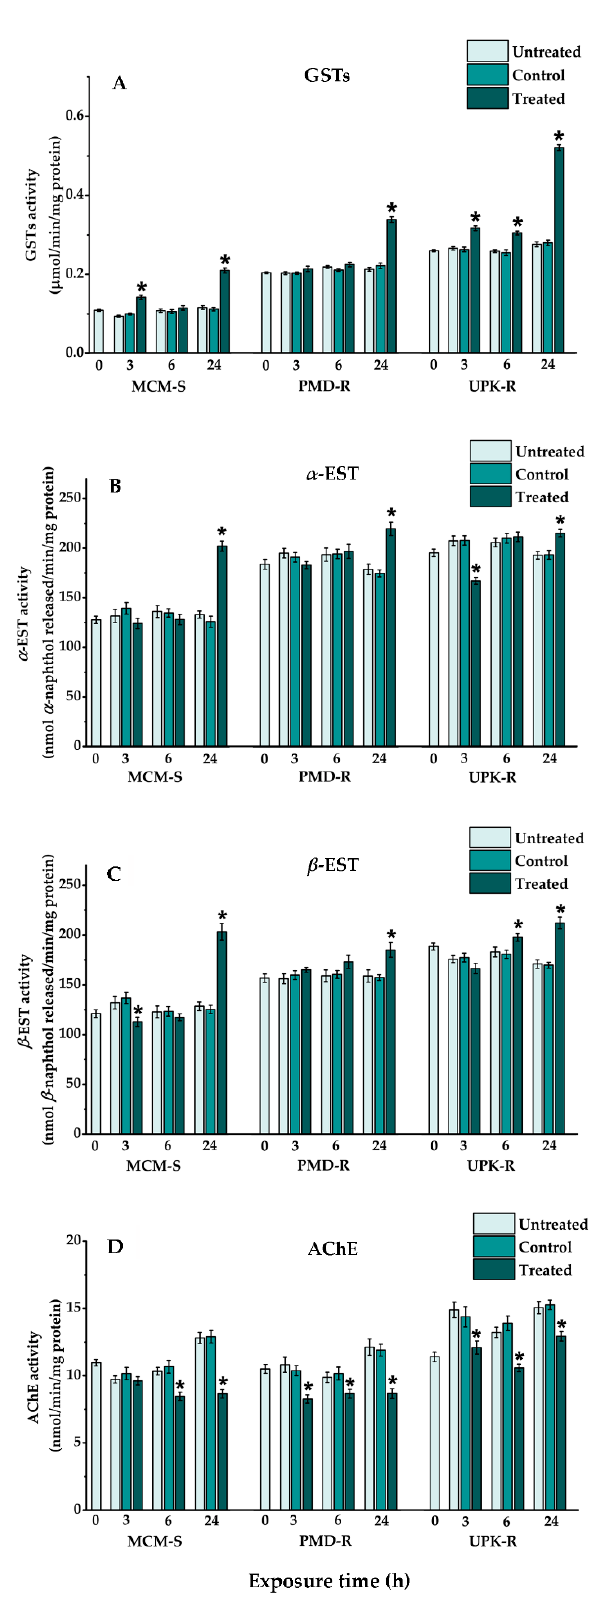
Figure 3. Activity levels of: GSTs ( A ); α -EST ( B ); β -EST ( C ); and AChE ( D ) in 4th instar larvae of the pyrethroid-susceptible (MCM-S) and resistant (PMD-R and UPK-R) Ae. aegypti after treatment with P. crispum oil (LC 50 ) for 3, 6 and 24 h. Vertical bars represent standard error ( ± SE) of six or ten biological samples from different preparations. The asterisk shows statistically significant differences of means among the different groups (Tukey’s HSD test, p < 0.05).